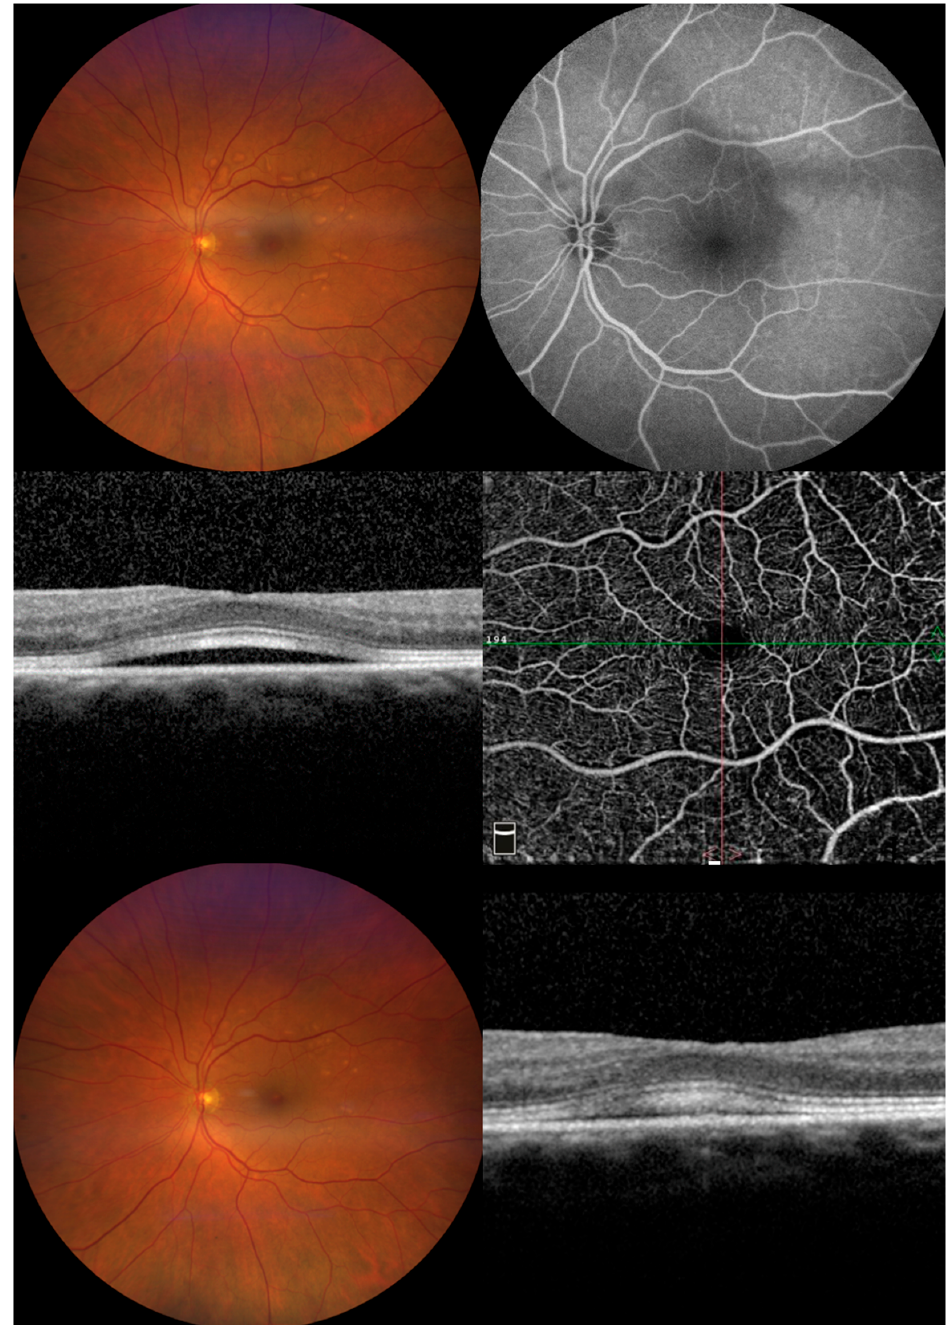
Figure 1. Images from patient number 6 affected by MEKAR. ( Upper left ) At two weeks from the start of treatment, the color picture shows multiple retinal pigment epithelial detachments in the posterior pole. ( Upper right ) FAG shows no leakage in the macular area; the presence of pooling corresponds to localized pigment epithelial detachment. CSCR was ruled out. ( Middle left ) Macular optical coherence tomography shows foveal serous neuro-epithelial detachment with thickening and high reflectivity of interdigitation zone. No sign of increased choroidal thickness or dilatation of choroidal vessels can be seen. ( Middle right ) Enface OCTA images of the superficial vascular plexus segmentation show no visible alteration. ( Bottom left ) At four weeks from the start of treatment, the color picture shows partial reabsorption of the multiple retinal pigment epithelial detachments in the posterior pole. ( Bottom right ) Macular optical coherence tomography shows a decrease in serous neuro-epithelial detachment.